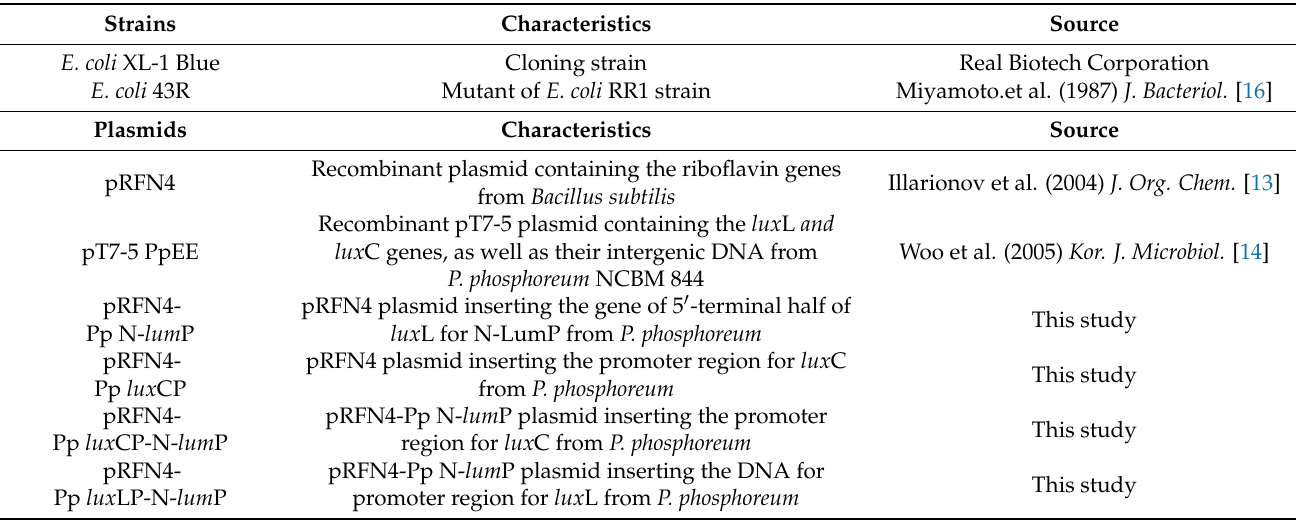
Table 1. Bacterial strains and plasmids used in this study.